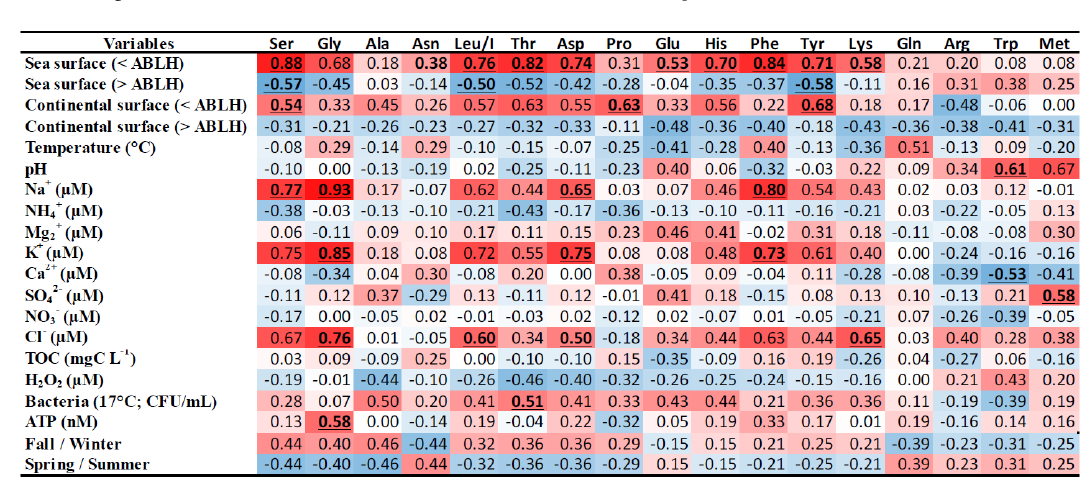
Table 3. PLS correlation matrix between AA concentrations and the “zone matrix” (sea/continental surface </> ABLH) from the CAT model, temperature, pH, cation and anion concentrations, TOC and H 2 O 2 concentrations, bacteria density (CFU mL − 1 ) and ATP concentra- tion, and the seasons (fall/winter and spring/summer) determined from 13 clouds sampled at the PUY. The highest correlations are displayed in dark red and the highest anticorrelations in dark blue. R> 0 . 5 (or R< − 0 . 5) with p values < 0.1 are